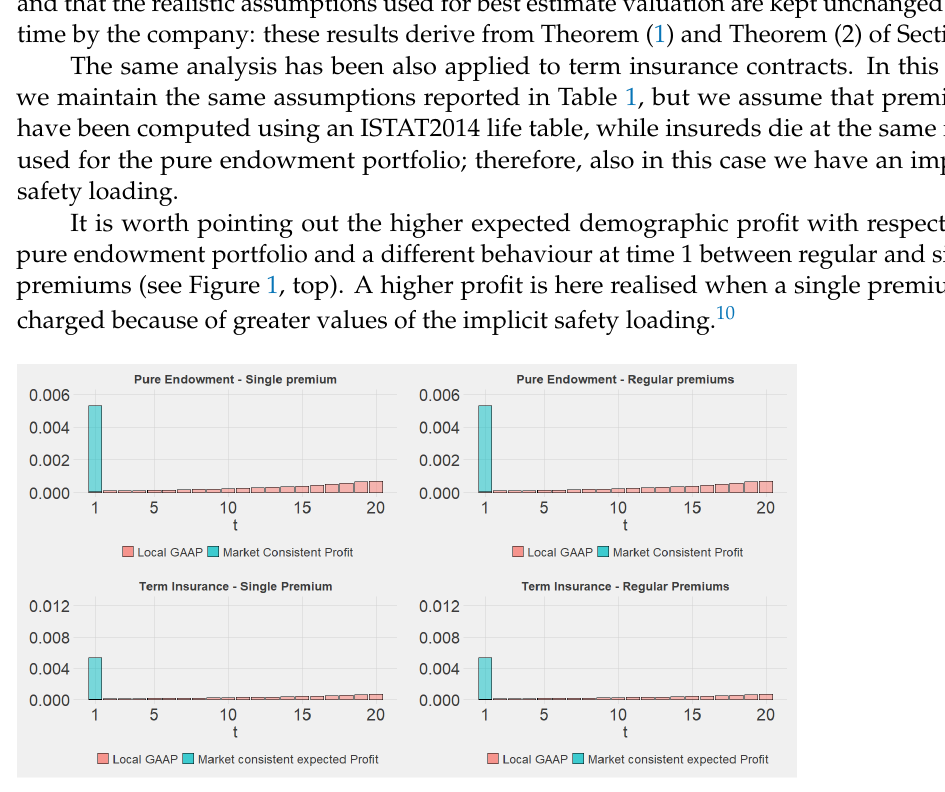
Figure 1. Pattern of expected demographic profit for a Pure Endowment and a Term